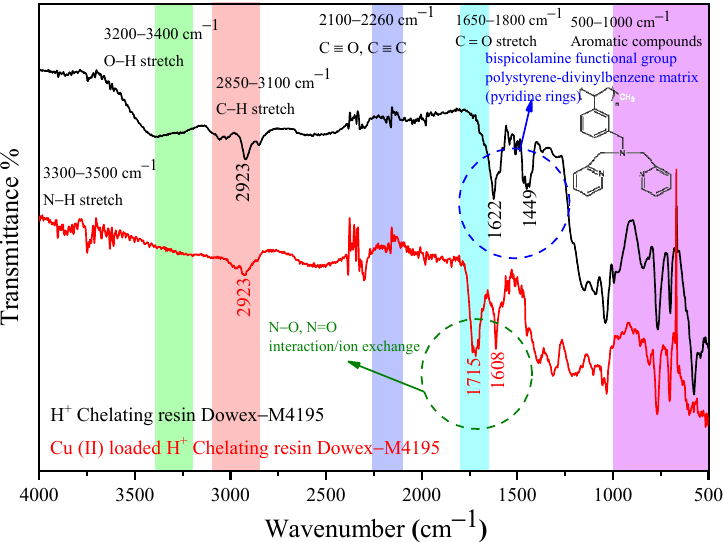
Figure 9. FTIR spectrum before and after Cu(II) was loaded onto H + Dowex-M4195 chelating resin.